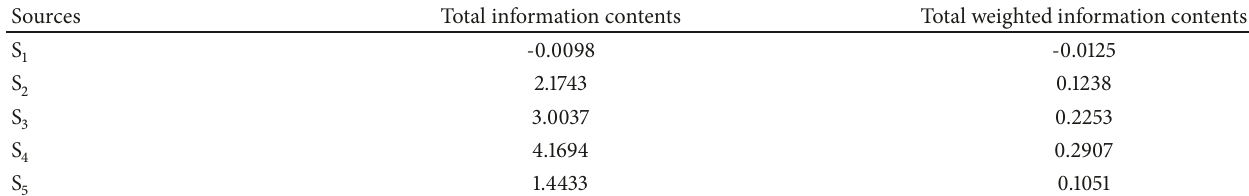
Table 15: Total information